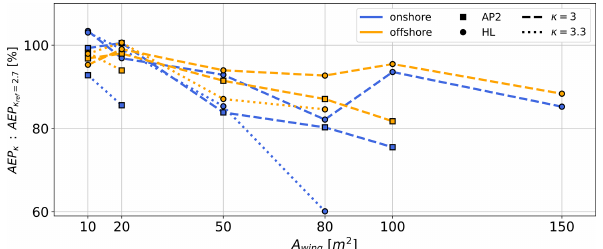
Figure 12. AEP ratio for mass-scaling exponent κ = 3 (dashed lines) and κ = 3 . 3 (dotted lines) relative to AEP of κ = 2 . 7 as a function of aircraft wing area A . The diagram summarizes data for both onshore (blue) and offshore (orange) locations as well as both sets of aerodynamic coefficients HL (circle) and AP2 (square). Re- sults are based on the average cycle power P derived from p5, p50, p95 wind velocity profiles within each of the k = 10 WRF- simulated clusters. Missing data points indicate that no feasible so- lution for any wind velocity profile was